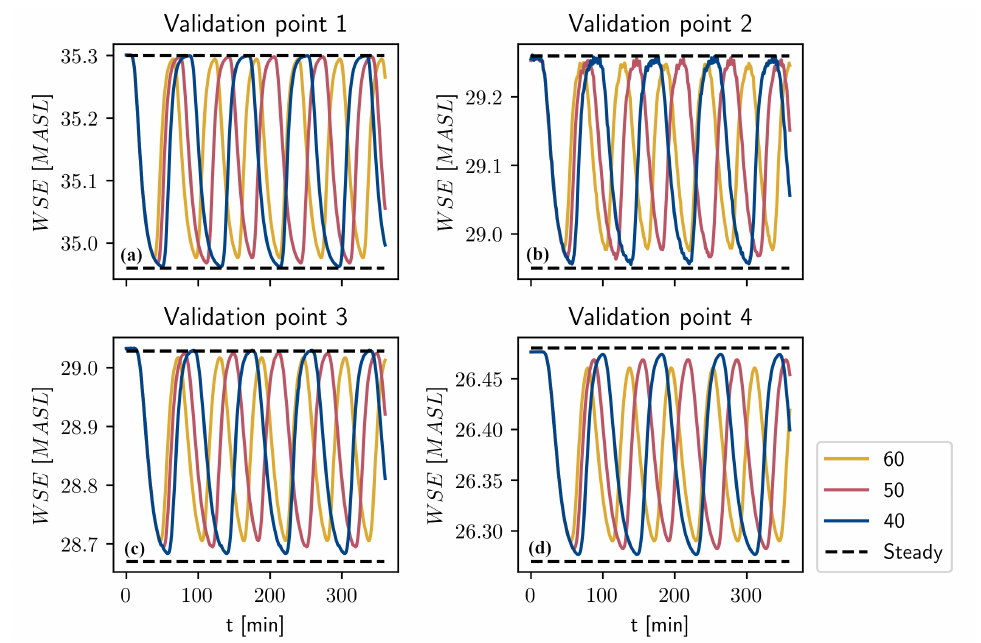
Figure 8. WSE for the points 1, 2, 3, and 4 given the flow scenarios with 40, 50, and 60 flow changes per day. ( a ) Validation point 1. ( b ) Validation point 2. ( c ) Validation point 3. ( d ) Validation point 4.